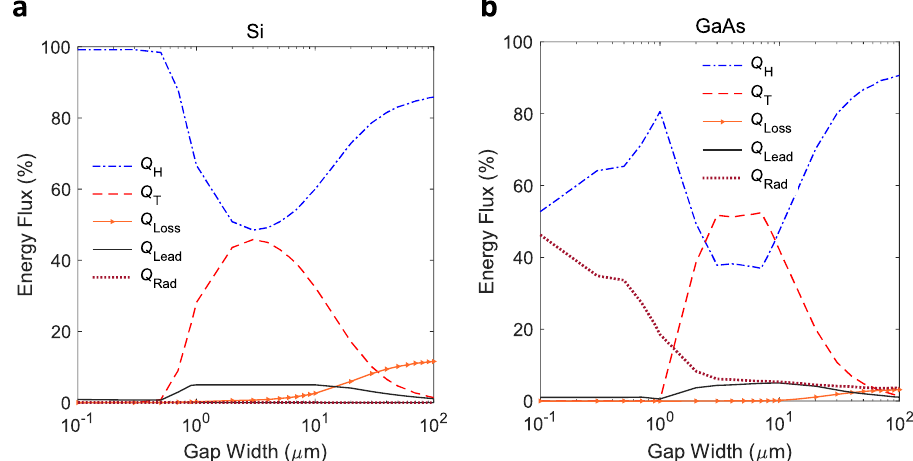
Fig. 3 The interplay among different energy exchange channels in a semiconductor thermionic device. The data are shown as a function of the interelectrode distance (also referred to as gap width) for a Si and b GaAs at MPP under a solar concentration ratio of 100. The symbols (starting from the top) represent the interelectrode radiative and thermionic exchange, emitter thermal radiation loss to the ambient, net heat conduction through the lead and non-equilibrium radiative recombination loss,